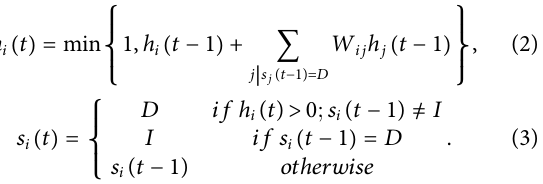
Algorithm for Power Systems section for assessing the vulnerability of power systems. The Vulnerable Lines Identi fi cation Process Based on the Electrical DR